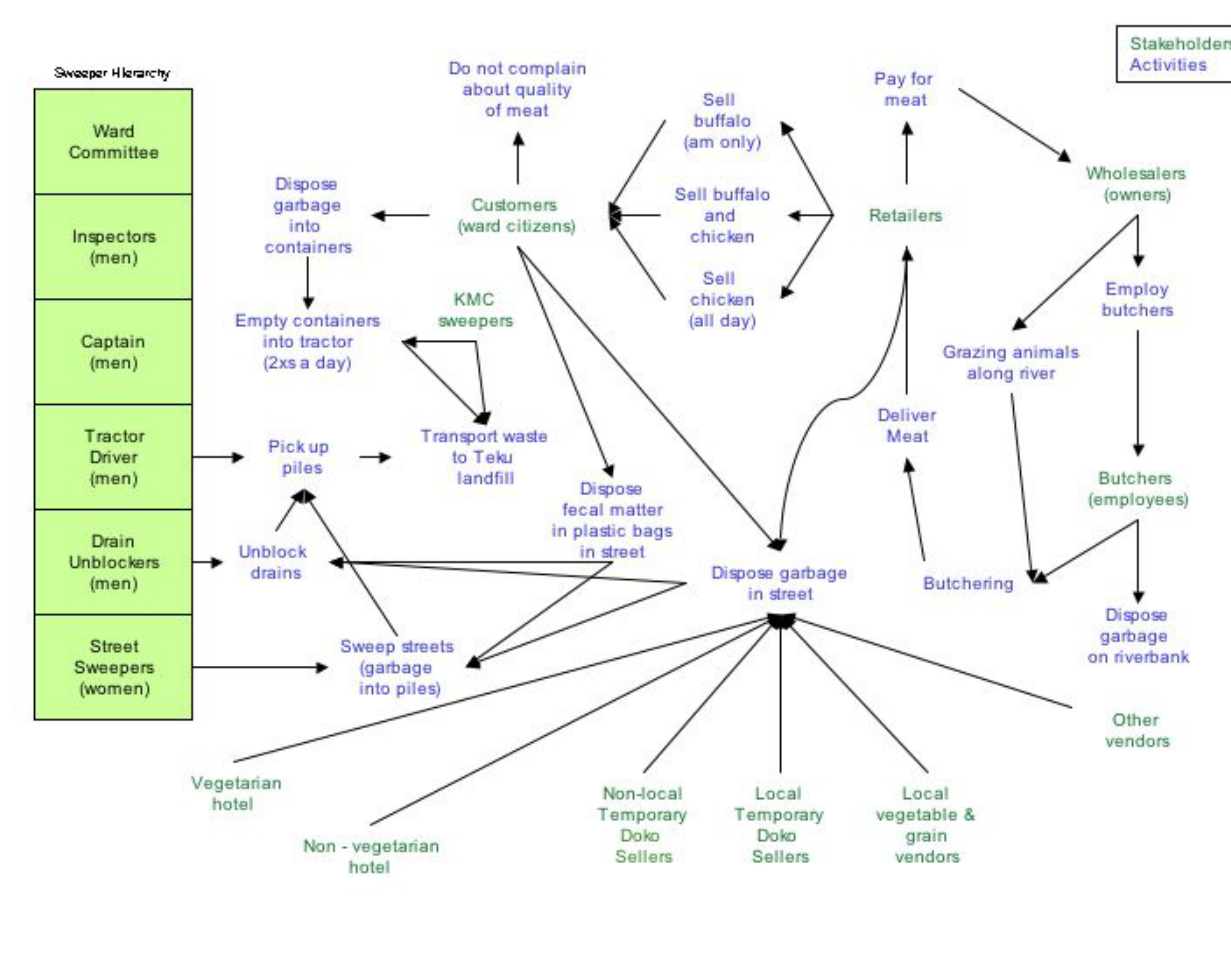
Fig. 7 . Production and management of street